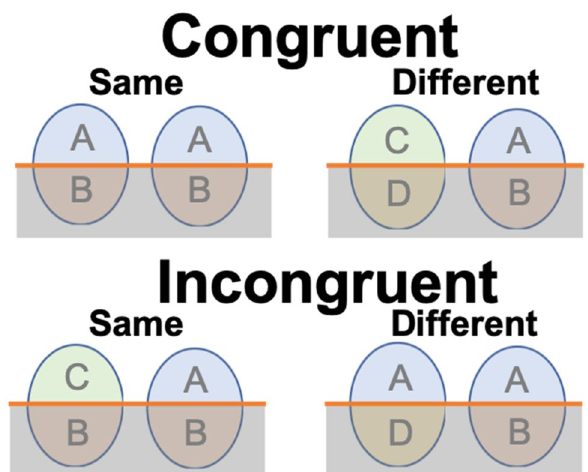
Figure 1. Complete composite paradigm to measure holistic processing. In each trial, participants were cued to attend to the top or bottom half of each stimulus pair and judged whether the attended halves were the same or different (attended halves shaded in grey in the figure). Holistic processing was demonstrated by a lower performance level in the incongruent condition than in the congruent condition, induced by the interference of the irrelevant halves. This paradigm has been widely adopted to measure for holistic processing in face recognition 10